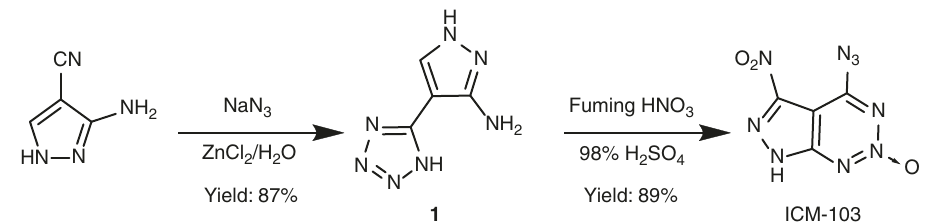
Fig. 1 Synthesis of ICM-103. Synthetic pathway for the synthesis of 6-nitro-7-azido-pyrazol[3,4-d][1,2,3]triazine-2-oxide (ICM-103)